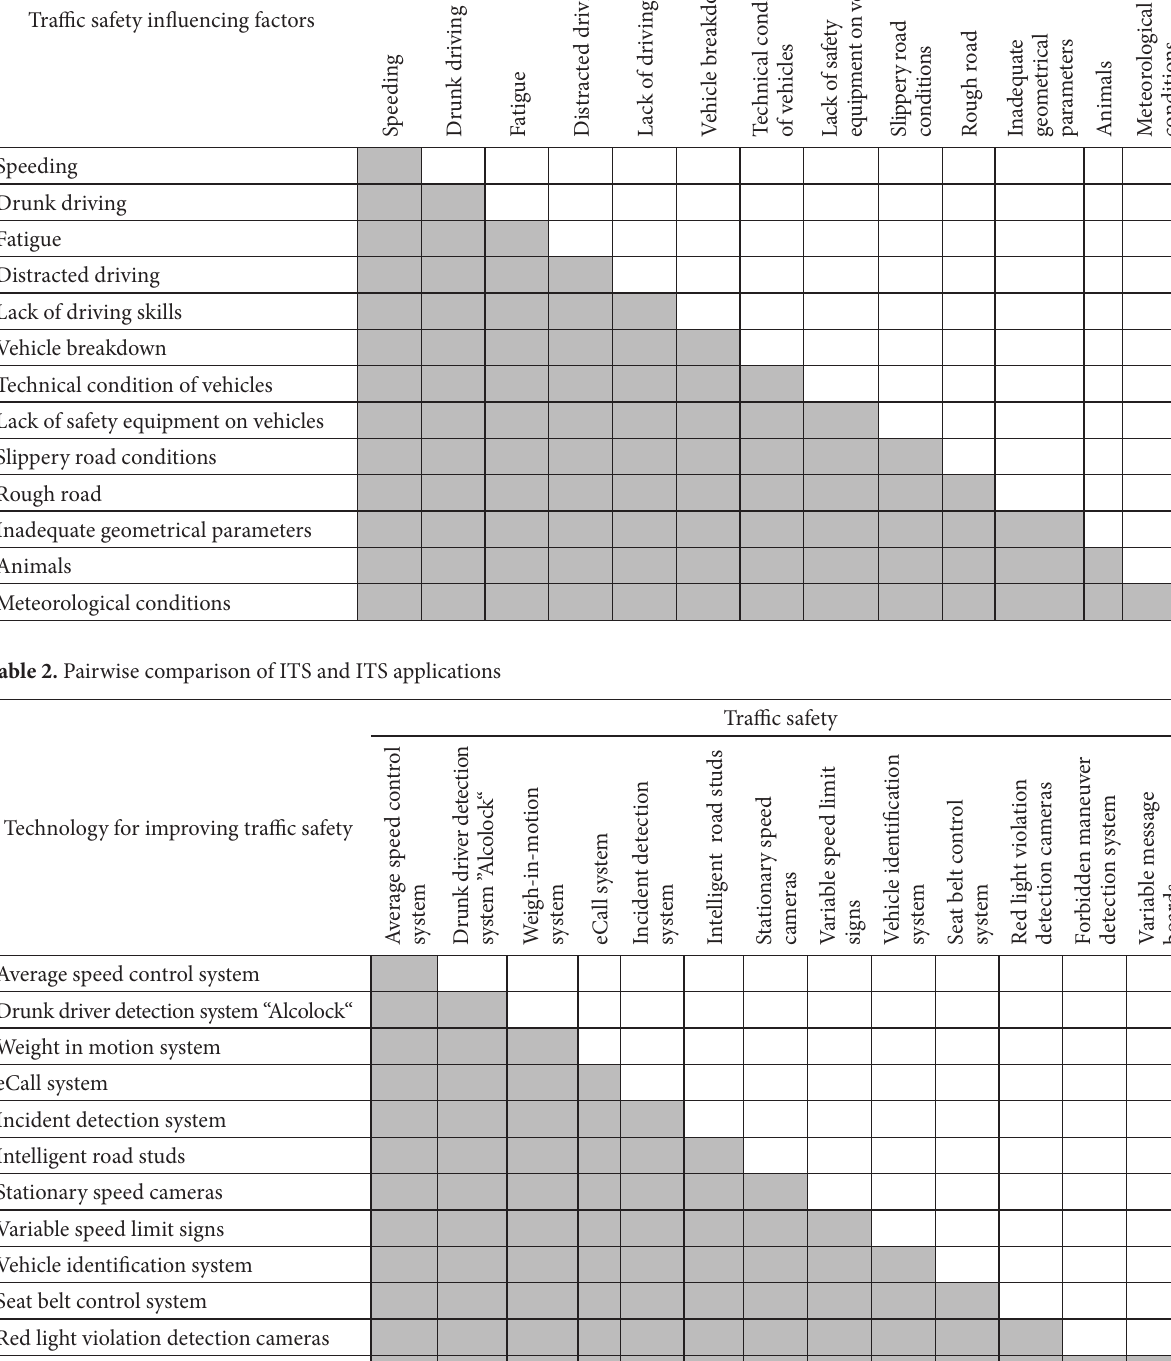
Traffic safety influencing factors